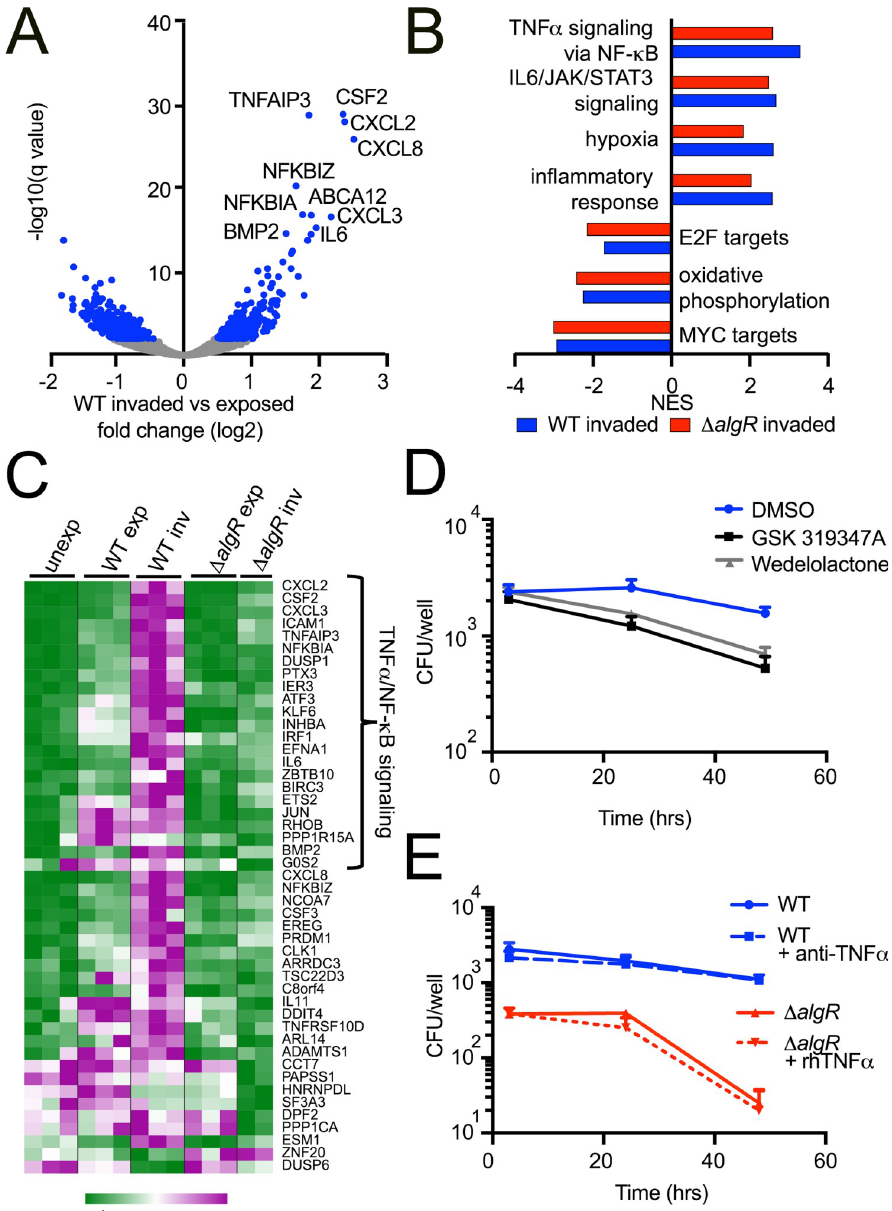
Fig 5. Activation of the host NF- κ B signaling pathway is correlated with bacterial survival rather than clearance. “ Unexposed”, “exposed” but uninfected GFP negative and “invaded” GFP positive cells were infected with WT or Δ algR PAO1 GFP-expressing bacteria and sorted 2 hpi. (A) Differential expression analysis of WT exposed and invaded cells. Differentially expressed genes (padj < 0.01) highlighted in blue; top 10 genes labeled. (B) Gene expression profiles of WT- and Δ algR -invaded cells were compared to unexposed cells. Normalized enrichment score (NES) for gene sets significantly enriched (FDR qval < 0.005) in each comparison are shown. (C) Heat map showing genes differentially expressed between WT-invaded and Δ algR- invaded cells. Genes belonging to the TNF α via NF- κ B gene set are highlighted. (D) Cells were pre-treated for 30 min with GSK 319347A or Wedelolactone before infection with WT P . aeruginosa at MOI = 10. At indicated time points, the number of intracellular bacteria was determined. (E) Cells were pre-treated with TNF α blocking monoclonal antibodies or recombinant TNF α 1 hour before infection with WT or Δ algR P . aeruginosa , respectively, at MOI = 10. At indicated time points, the number of intracellular bacteria was determined.